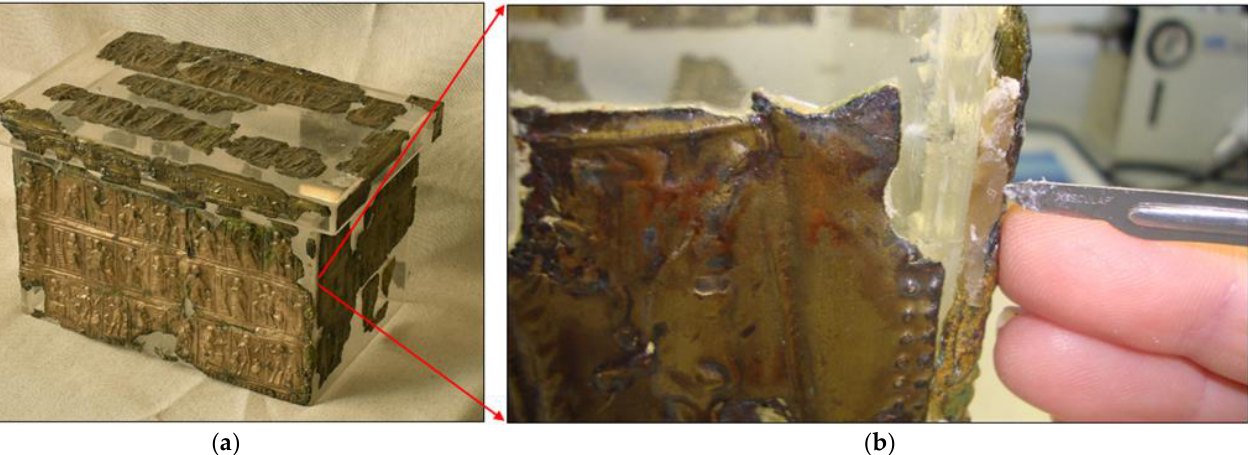
Figure 1. ( a ) Reconstruction of the wooden chest with brass tiles; ( b ) Presentation of taking samples from the chest (brass part and adhesive).